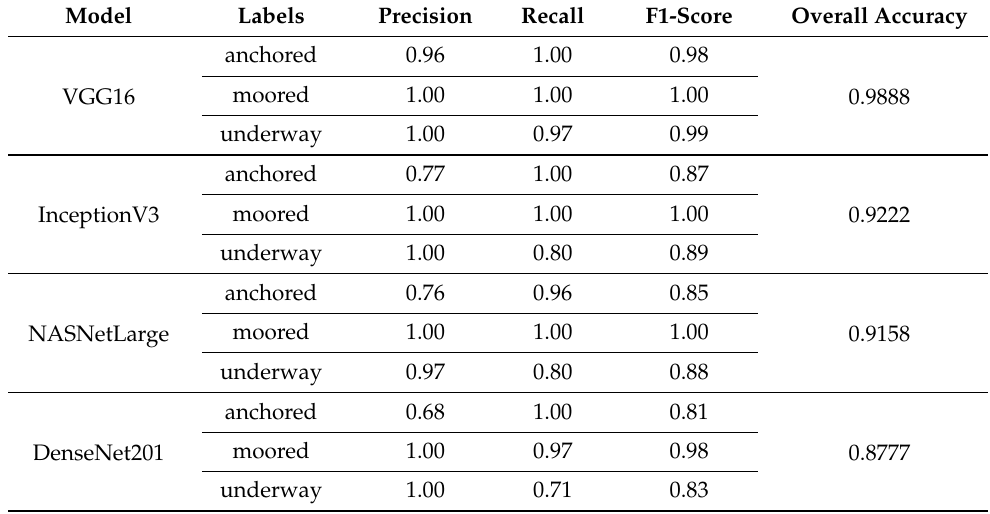
Table 3. Classification performance obtained from different pre-trained CNN models for Pattern A.